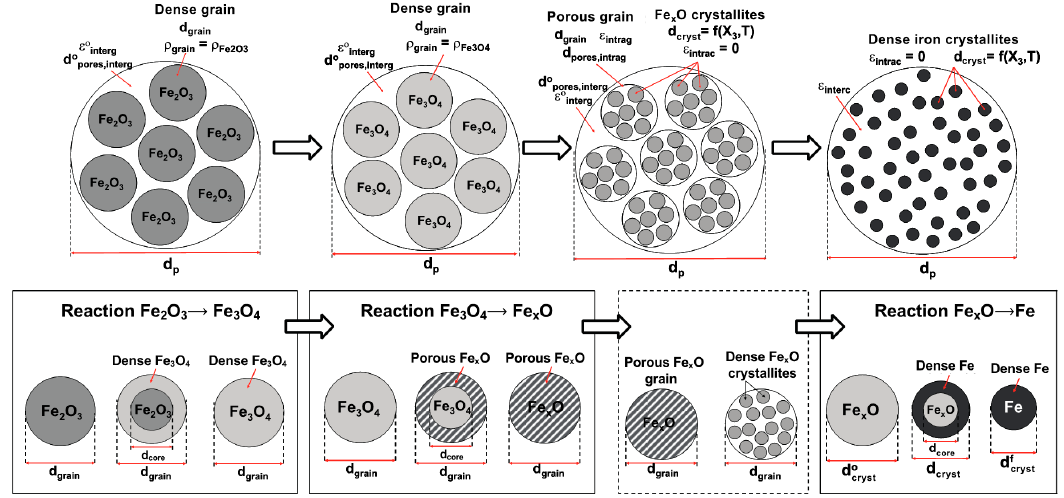
Figure 7. Modeled representation of the pellet (top row) and grain (bottom row) evolution.